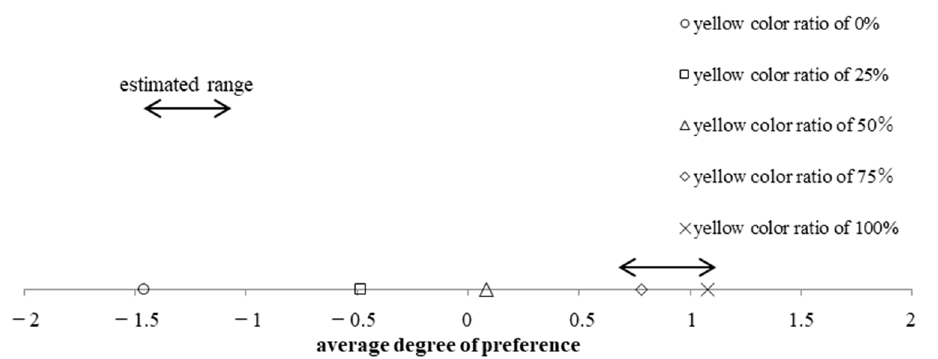
Figure 9. In terms of yellow color ratio brightness perception, the color ratio of 100% was the brightest result. There was no significant difference between the 100% and 75% yellow color ratios.